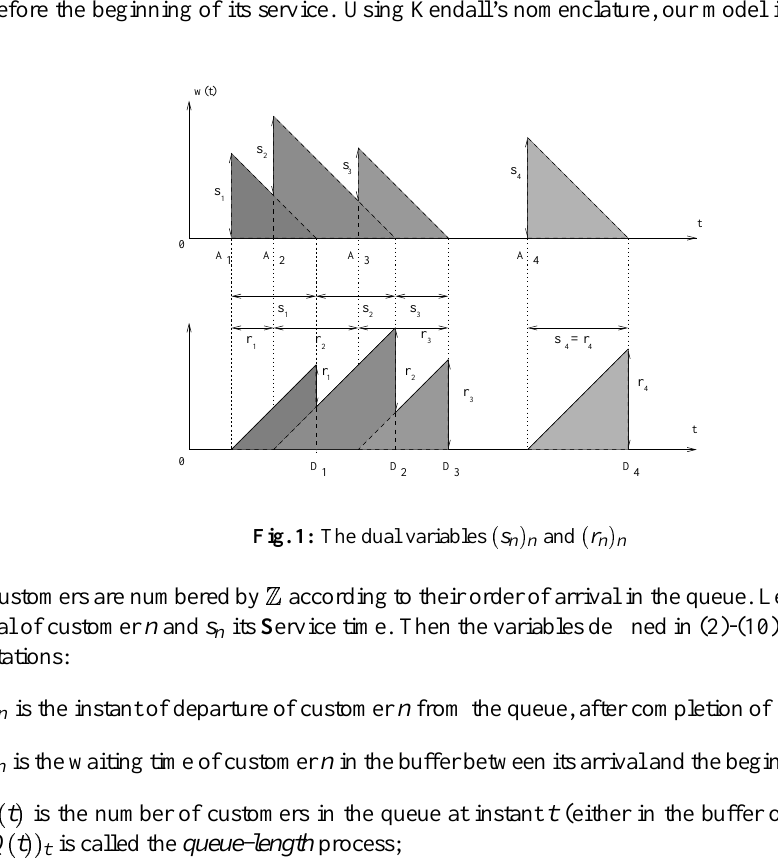
s n n and (cid:1) (cid:3)